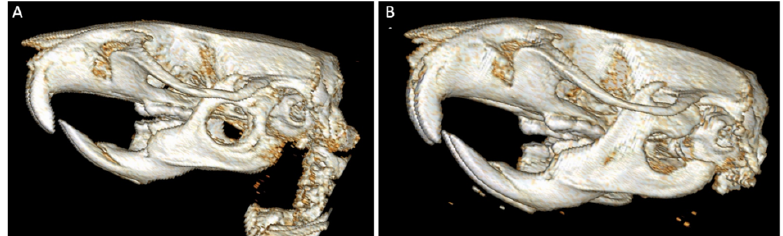
Figure 5. Three-dimensional CT scan renderings of mandibular defect. Image ( A ) displays the ideal placement of the critical-sized (5 mm diameter), full-thickness bone defect on rodent hemimandible. Image ( B ) demonstrates defect placement that is too far caudal on the hemimandible. Both images provide appreciation for the difficulty of completing quantitative analysis due to the small defect and animal size.